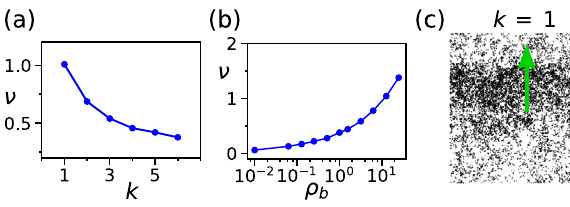
Fig. 8 Observed bands for the k -nearest neighbor interaction ( k NN) in homogeneous environments. k is the number of neighbors and the density of obstacles is fi xed at ρ o = 0. a Rewiring ν versus k for a system with N b = 625 particles (particle density ρ b = 1.0), interacting with k NN. b Rewiring ν measured for the system with N b = 625 at different particle densities ρ b by varying box size L ( k = 6). c) Snapshot showing band formation for k NN interaction with k = 1. The black dots represent particles, and the green arrow shows the moving direction of the band. Noise intensity is η = 0.55 for all the